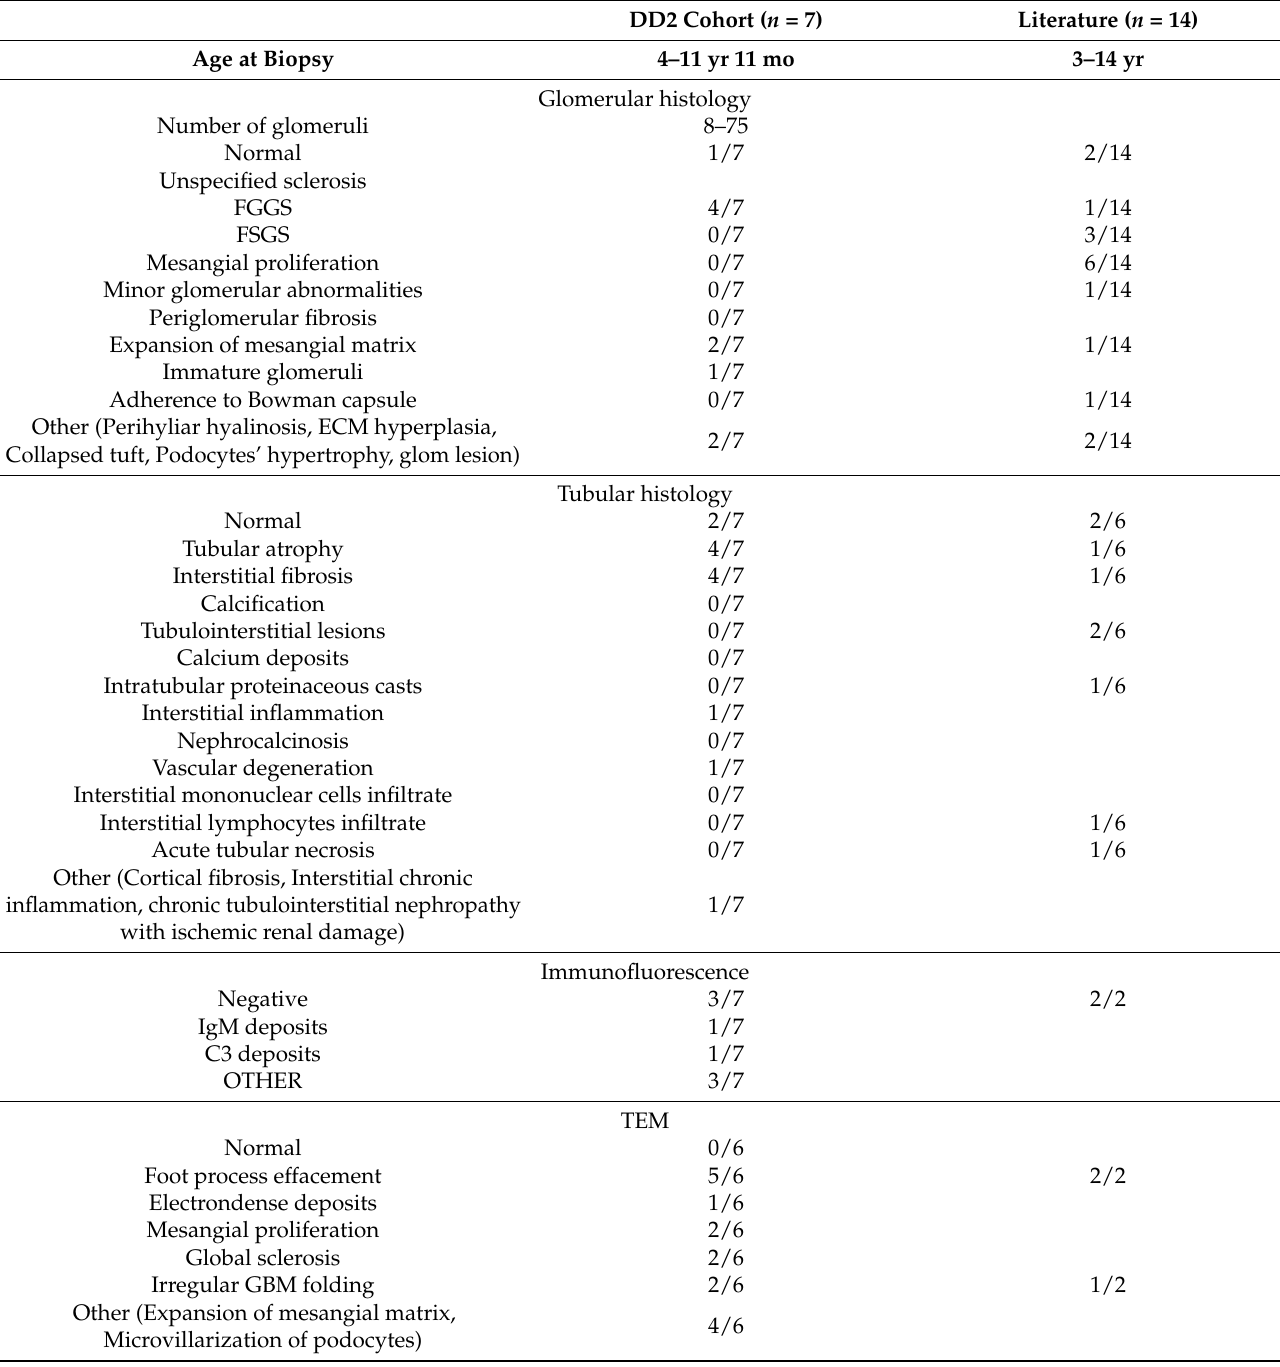
Table 2. Histopathological data from 21 DD2 kidney biopsies. Data are shown as number of cases with each characteristic within all described cases. FGGS: Focal global glomerulosclerosis, FSGS: Focal segmental glomerulosclerosis, GBM: Glomerular basement membrane, TEM: Transmission electron